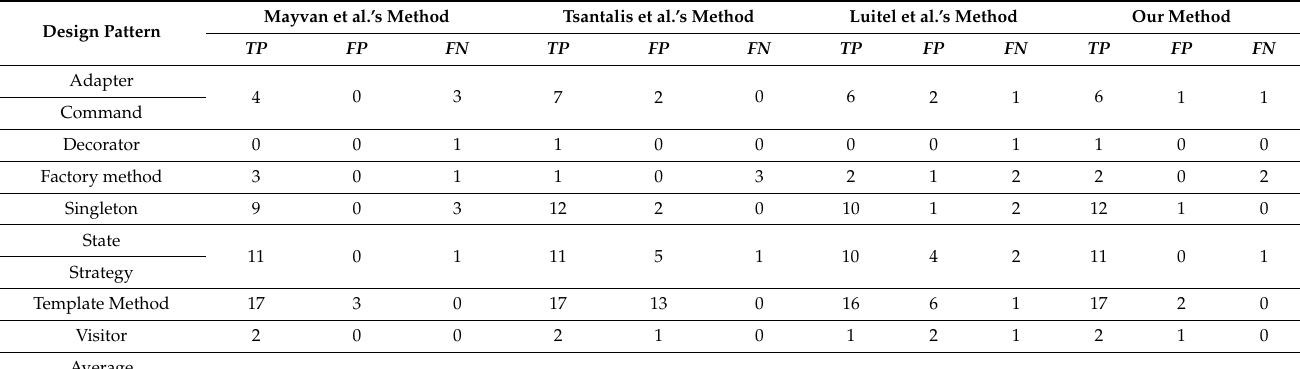
Table 3. The number of true positive instances, the number of false positive instances and the number of false negative instances in JRefactory